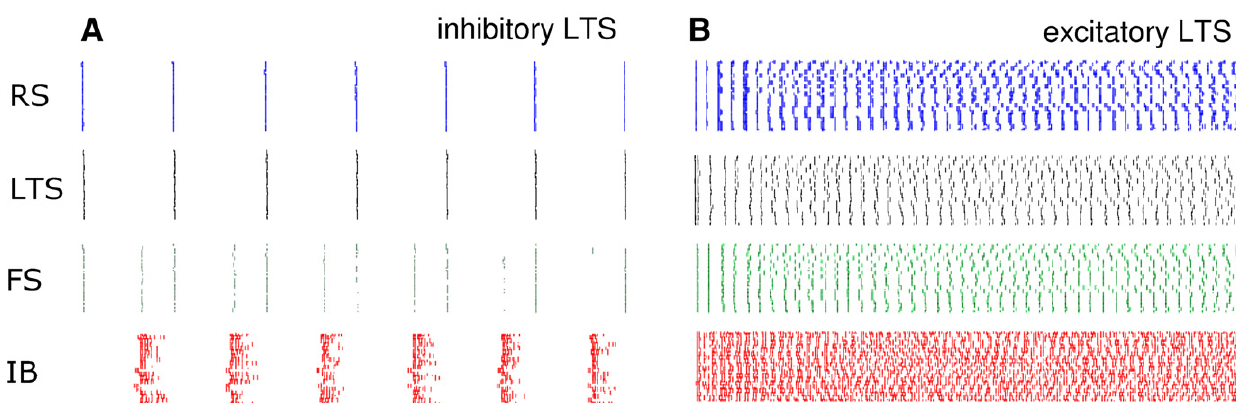
Figure 5. Excitatory LTS neurons do not foster period concatenation in simulations. Simulation results comparing 0.5 s epochs of spike activity (shown as rasters) in each of the 4 cell types, using inhibitory LTS cell output (A) and excitatory LTS cell output (B) . All other model parameters were kept the same. With excitatory LTS cells note the absence of pauses in the high frequency fi ring rates in all cells. RS = regular spiking, superfi cial layer neuron, LTS = low threshold spiking superfi cial layer neuron, FS = fast spiking superfi cial layer interneuron, IB = layer V intrinsic bursting neuron.